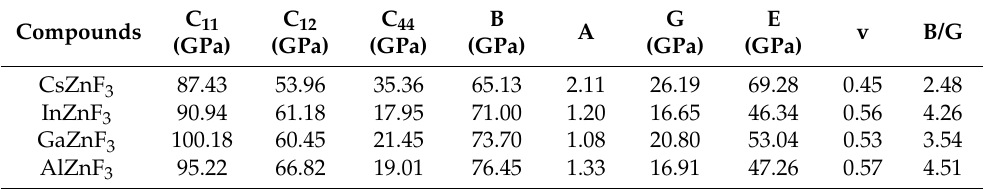
Table 2. Calculated values for the elastic constants of XZnF 3 (X = Al, Cs, Ga, In). The computed cubic elastic constants C 11 , C 12 , C 44 , the bulk modulus B, anisotropy factor A, Young’s modulus E, Poisson ration υ , Shear modulus G, and the Pugh ratio B/G.